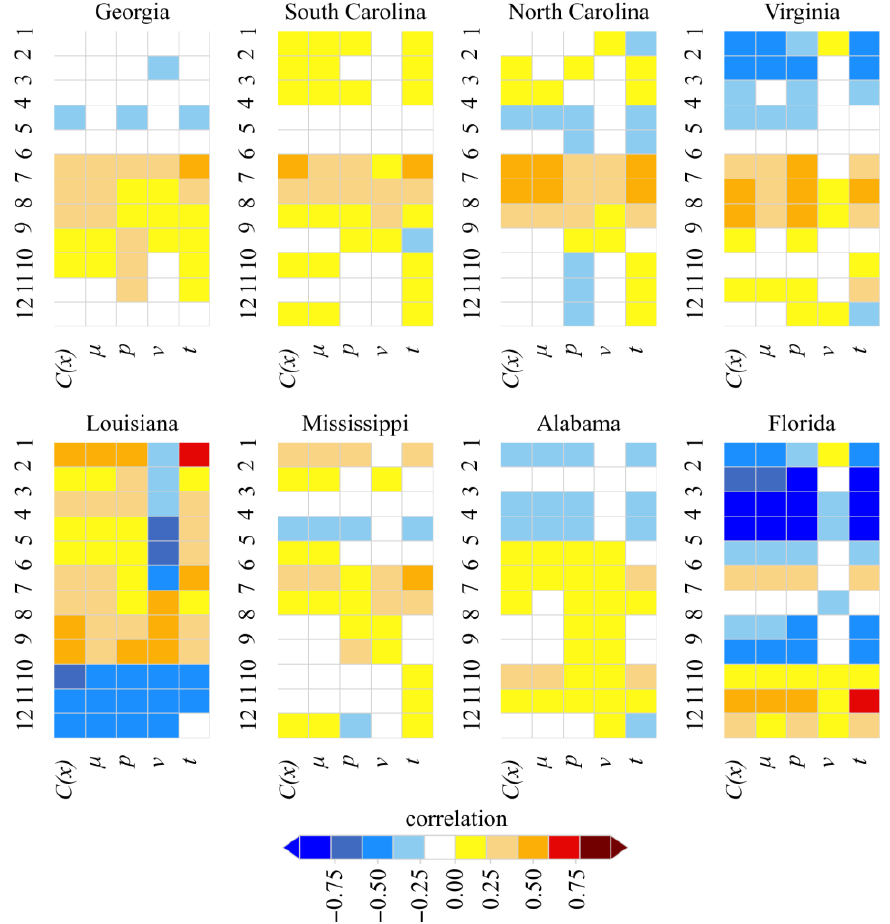
Figure 5. Spearman rank correlations between mean monthly precipitation and streamflow drought parameters, divided by state; C(x) — periodicity of streamflow drought occurrence, μ— mean length of process memory, p — number of periods with streamflow drought, v — mean monthly volume, t — mean duration.